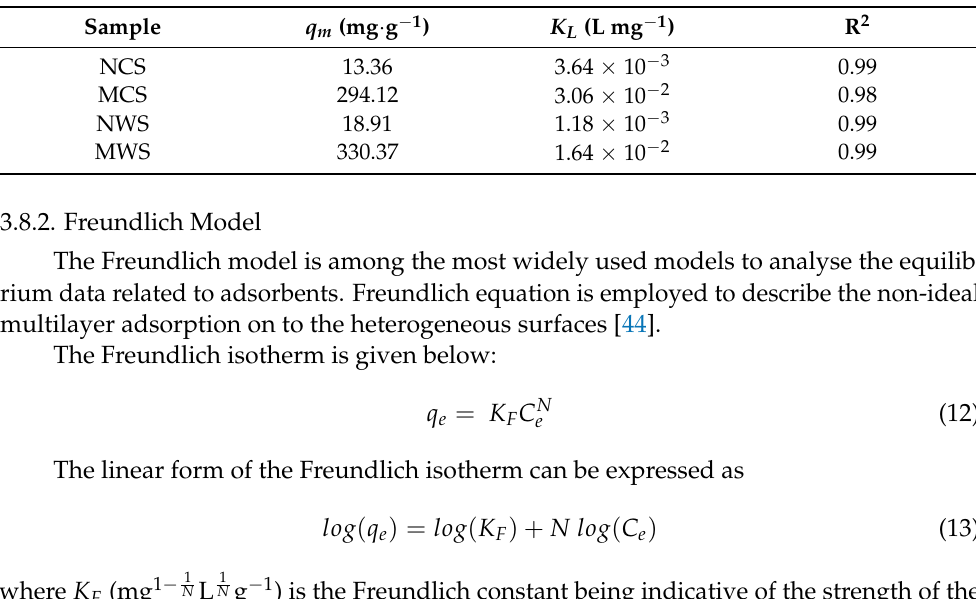
Table 5. The Langmuir isotherm constants for removal of Pb(II)